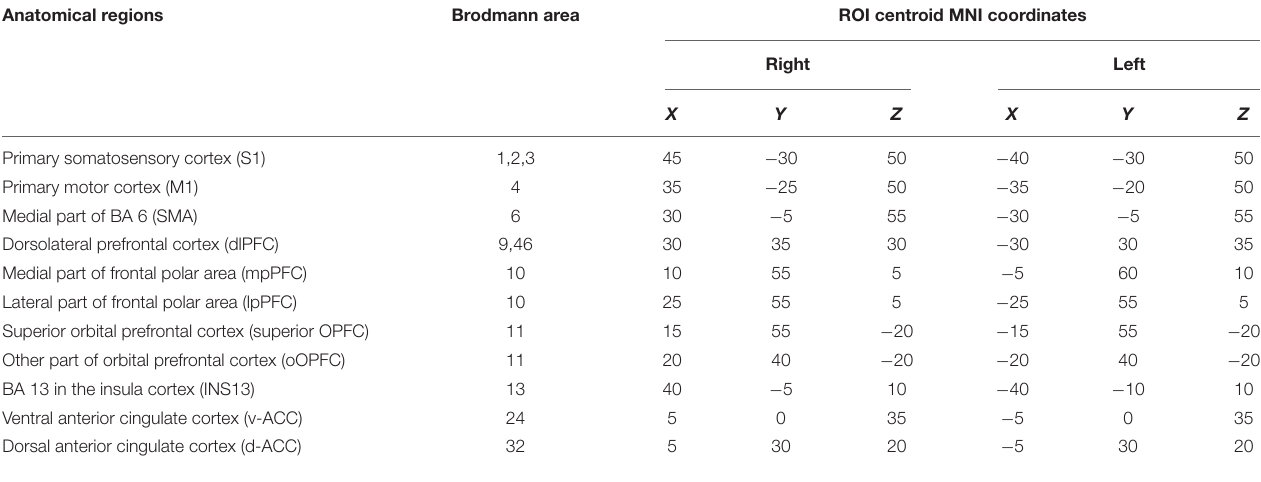
TABLE 1 | Cerebral regions of interest used for the lagged phase synchronization analysis. Anatomical